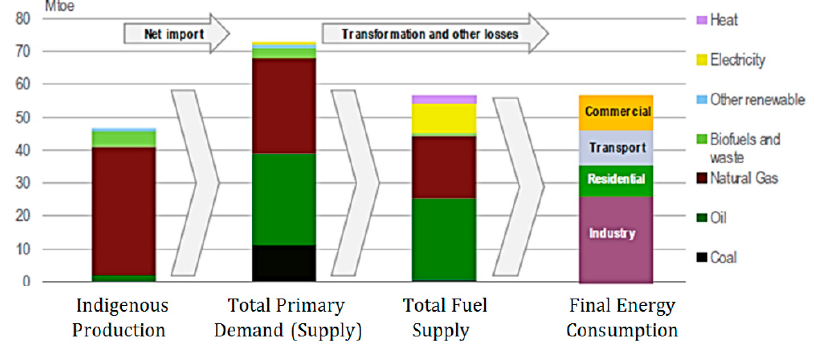
Figure 4. Explanation of energy demand and supply, own calculation based upon [37].